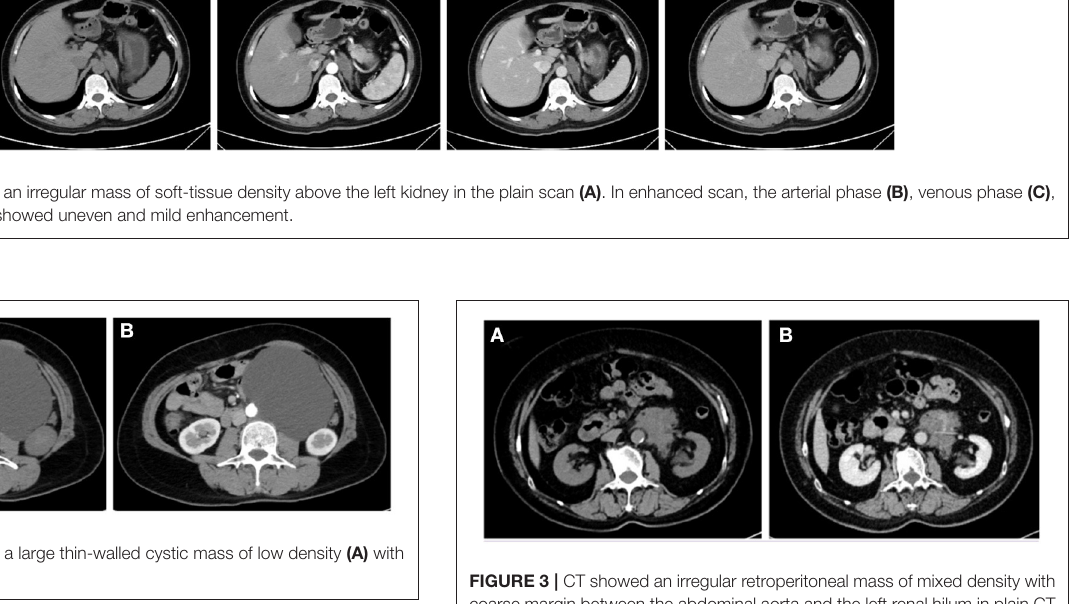
components. Half of our cases showed blood flow signals, mainly in the shape of dots or